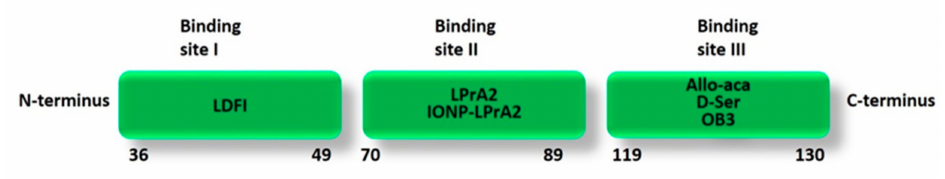
Figure 6. Schematic representation of the main leptin peptide analogues with anti-tumor activity based on human leptin binding sites. LDFI is based on the sequence 39–42 (LDFI) of leptin binding site I; LPrA2 and IONP-LPrA2 are based on the amino acid sequence 70–95 of leptin binding site II; Allo-aca (H-alloThr-Glu-Nva-Val-Ala-Leu-Ser-ArgAca-NH 2 ) and D-Ser (H-(D)Ser-Glu-Nva-Val-Ala- Leu-Ser-(N-Me)Arg- β Ala-NH 2 ) are based on the modified amino acid sequence 121–129 of leptin binding site III; OB3 is based on the amino acid sequence 116–122 of leptin binding site III. The pegylated form of this antagonist, PEG-LPrA2, attenuated the expression of vascular endothelial growth factor (VEGF) and vascular endothelial growth factor receptor type 2 (VEGFR2) in MCF-7 (ER + human breast cancer cells) and MDA-MB-231